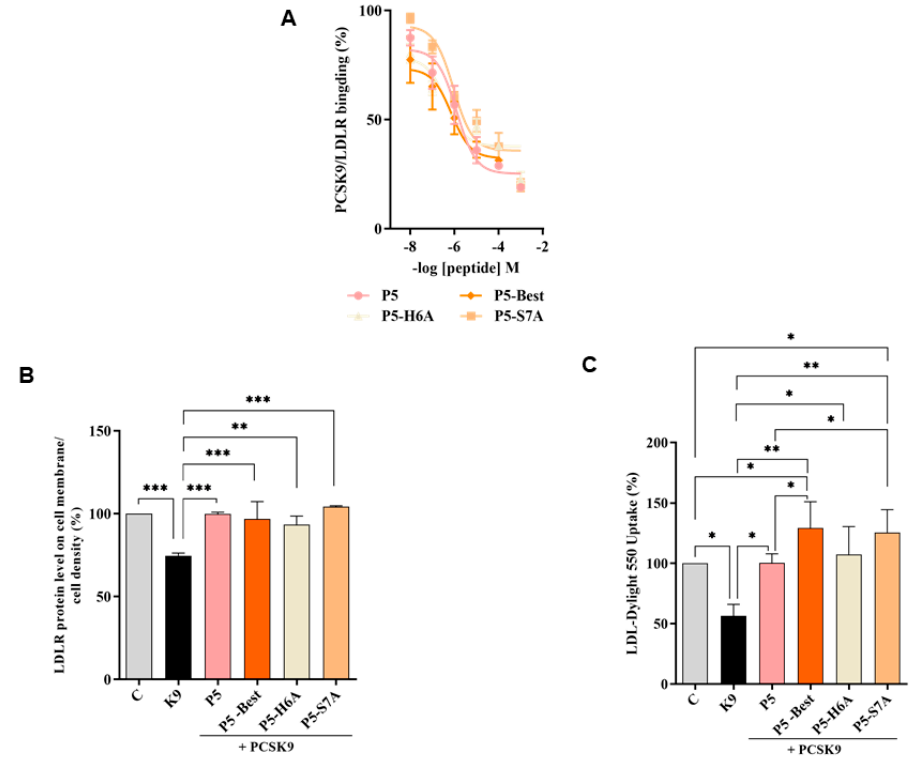
Figure 3. Inhibition of the PPI between PCSK9 and LDLR. ( A ) Impairment of the protein-protein interaction between PCSK9 and LDLR. ( B ) The treatment of HepG2 cells with PCSK9 (K9 in the graphs, 4 µ g/mL) reduced the active LDLR protein levels localized on the surface of the cells, which were restored by P5 and P5 analogs (50 µ M). ( C ) The decreased functional ability of HepG2 cells to absorb LDL from the extracellular space observed after incubation with PCSK9 (4 µ g/mL) improved after treatment with P5 and P5 analogs (50 µ M). The data points represent the average ± SD of four independent experiments performed in duplicate. Data were analyzed using one-way ANOVA, followed by Tukey’s post-hoc test; (*) p < 0.05, (**) p < 0.01, and (***) p < 0.001. C: control